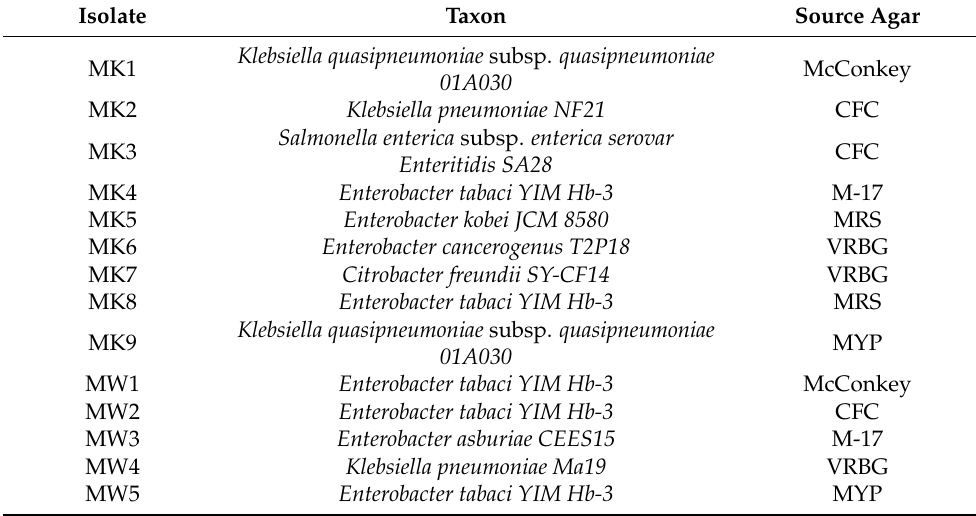
Table 2. Bacterial isolates recovered from carrot.